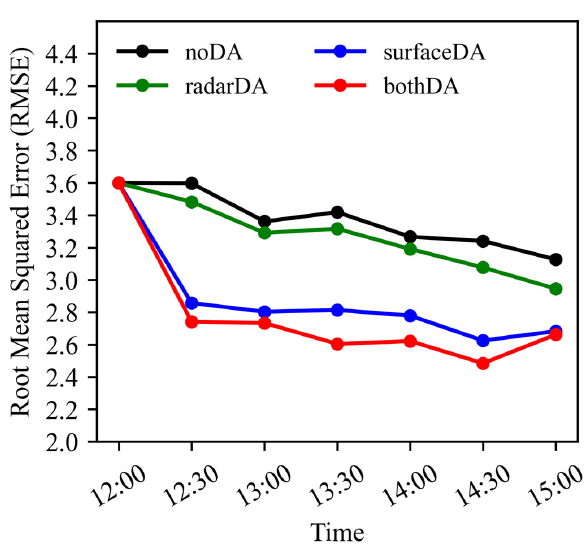
Figure 10. The Root Mean Squared Error (RMSE) for the surface temperature from 1200 to 1500 UTC 11 July 2014 for noDA (black dotted line), radarDA (green dotted line), surfaceDA (blue dotted line) and bothDA (red dotted line) experiments. The score area is the same as the panel area in Figure 9.